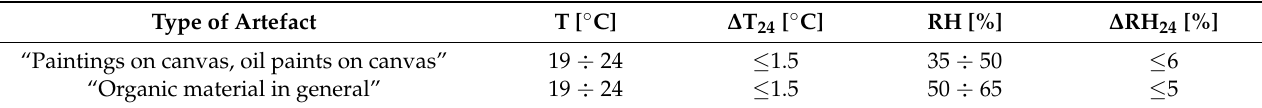
Table 5. Reference values recommended by the Italian D.M. 10.05.2001 [16] for the conservation of “paintings on canvas, oil paints on canvas” and “organic material in